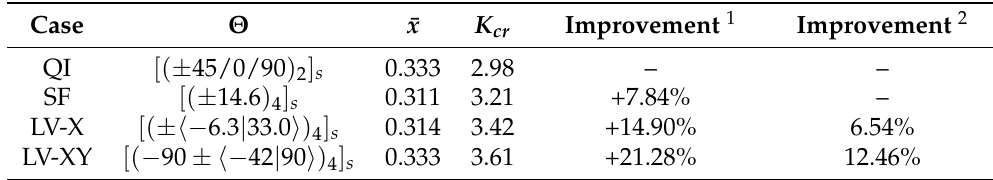
Table 4. Optimal designs and results of the stiffened plate with a central cutout subjected to uniform axial displacement (w/o AFP manufacturing